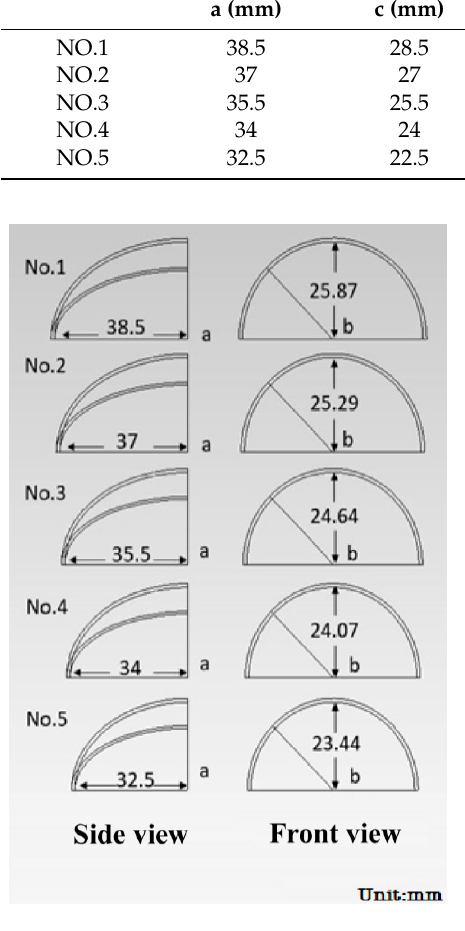
Figure 3. Schematic cross-sectional views of primary ellipsoidal reflector Nos. 1 to 5.